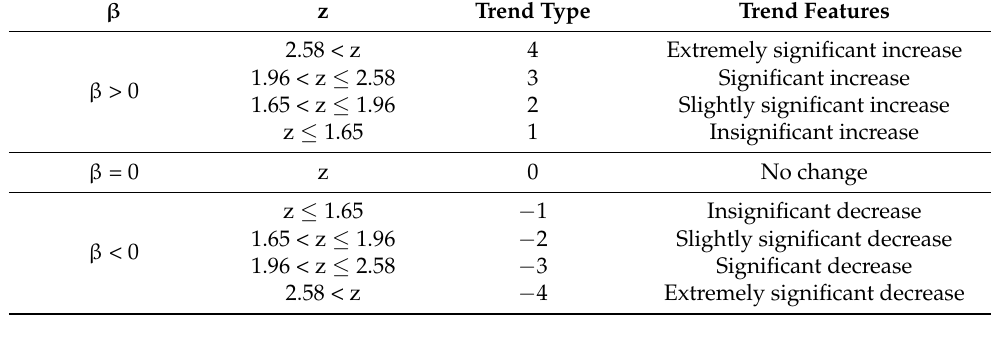
Figure 3. The spatial distribution of SPEI, LAI, ET and GPP trends from 2000 to 2020. LAI, ET and GPP are expressed using the same color table. SPEI shows significant increase trend ( p < 0.05) throughout the study area, expressed in a stretched mode.